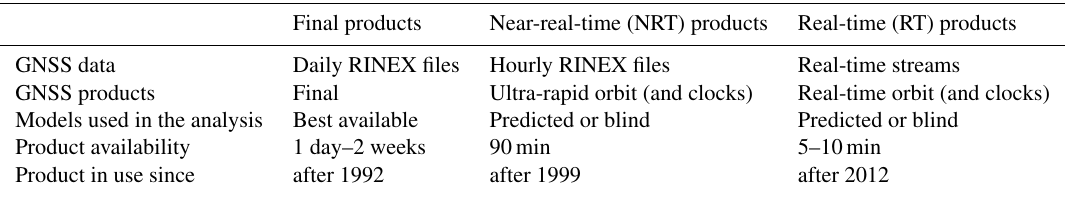
Table 1. Characteristics of the different GNSS tropospheric product